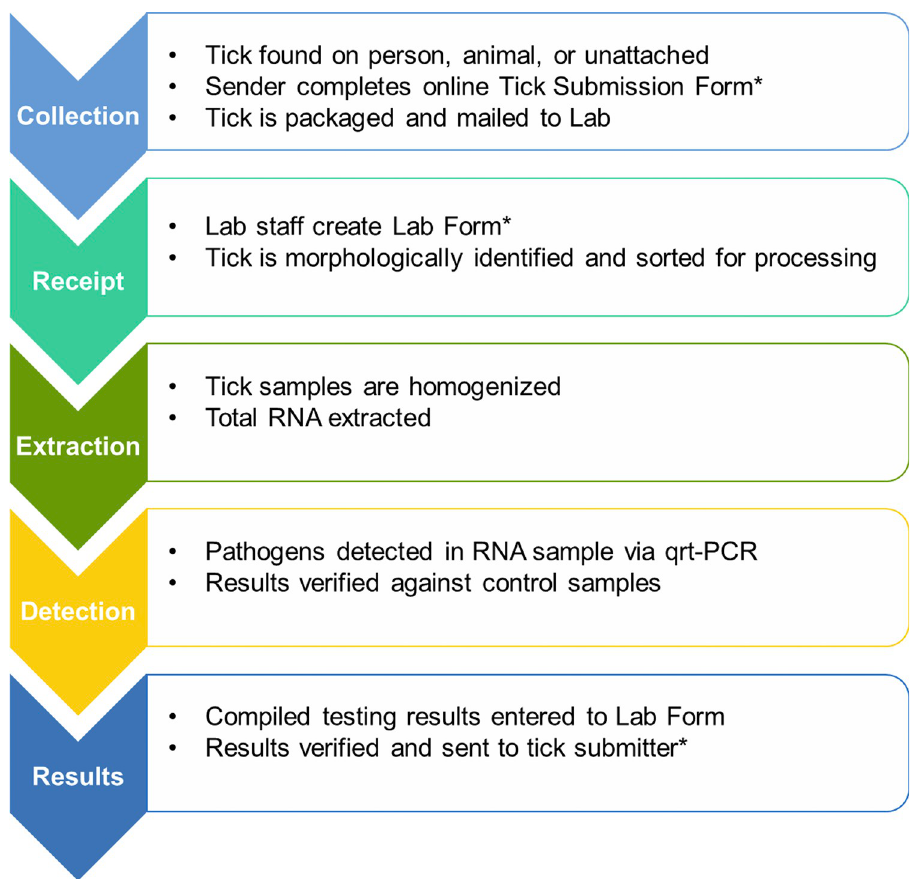
Fig 1. Overview of tick surveillance workflow. Tick surveillance sample processing covers five major functions, each with multiple steps. At steps designated with ( � ), an automatic notification is sent to the email linked to the Tick ID to provide status updates to the tick